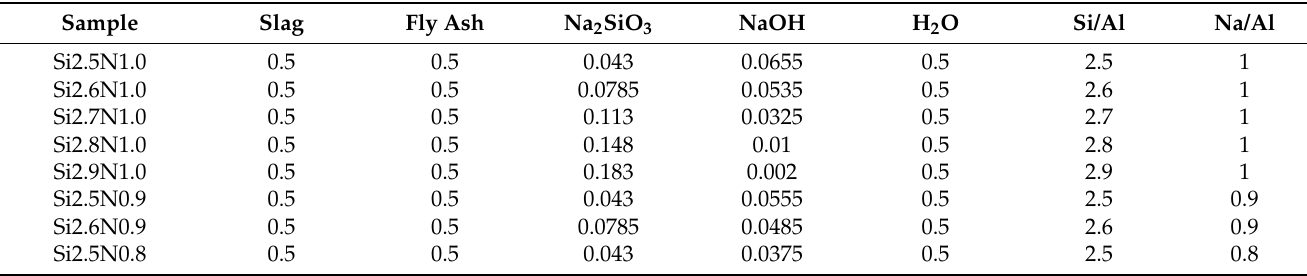
Table 2. Mix compositions of geopolymer